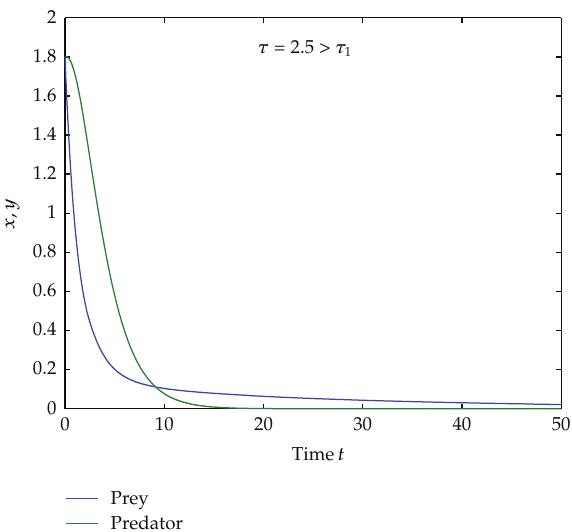
Figure 1: The equilibrium E 0 is globally stable when τ (cid:6) 2 .